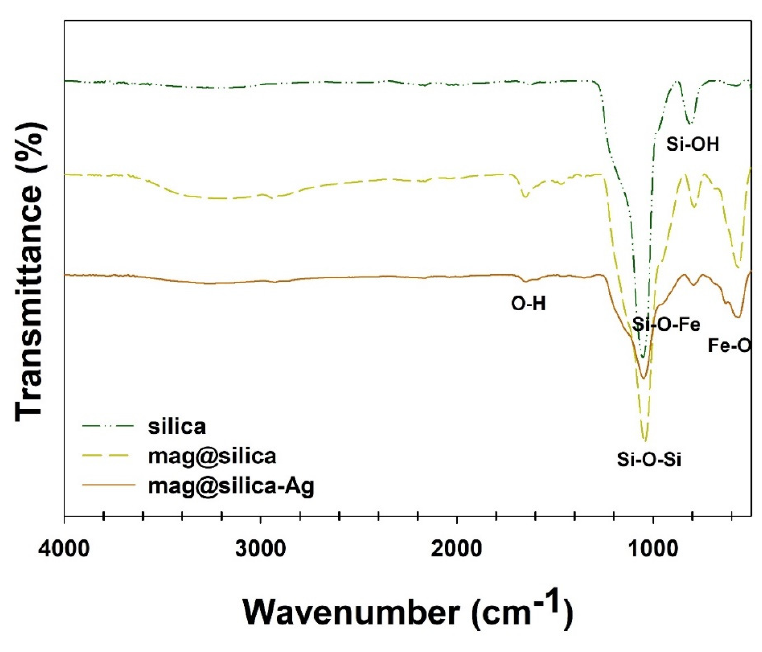
Figure 6. FT-IR spectra of silica, mag@silica, and mag@silica-Ag Figure 6. FT - IR spectra of silica, mag@silica, and mag@silica-Ag composites.